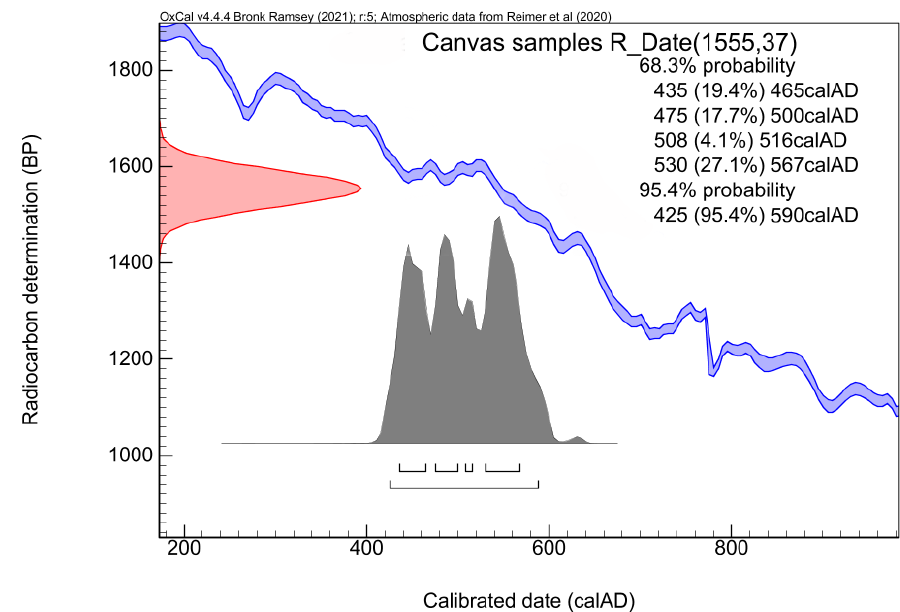
Figure 8. Calibration of the conventional radiocarbon age (1555 ± 37 years BP) measured for the canvas fragment: the IntCal20 calibration curve (conventional radiocarbon age vs. calendar date) is represented in blue; the measured conventional radiocarbon age is treated as a normal-distributed variable and represented in red on the y axis. The grey area on the x-axis represents the distribution of the calibrated age. The calibrated age intervals, calculated at a 68% and 95% level of probability, are reported in details in the graph.